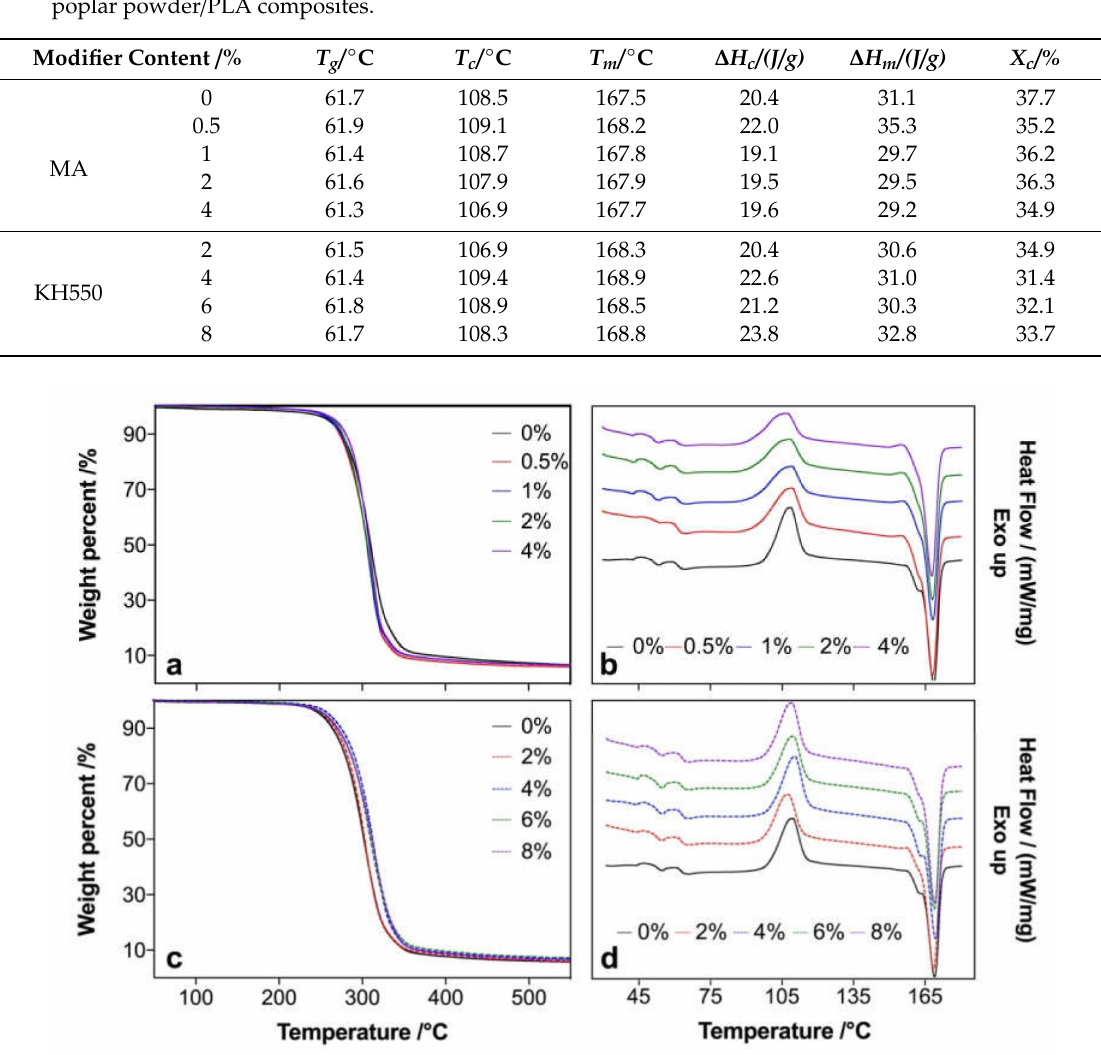
Figure 3. TG ( a , c ) and DSC ( b , d ) of MA- ( a , b ) and KH550- ( c , d ) modified poplar fiber / PLA